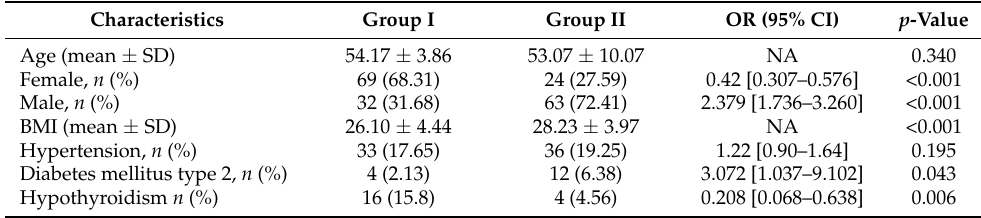
Table 2. General demographic and clinical characteristics.